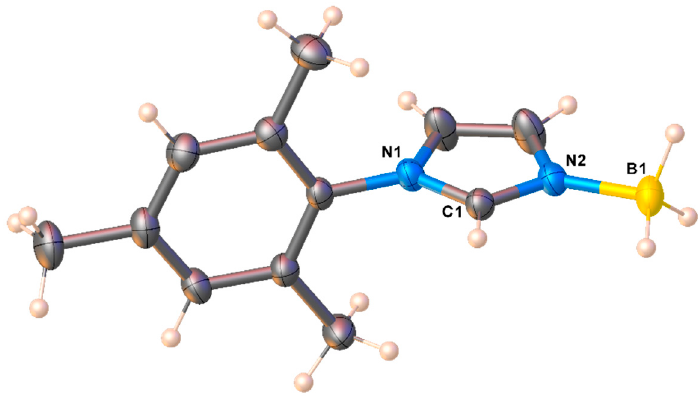
Figure 2. Molecular structure of (HIm Mes )BH 3 (2). There are two chemical similar but crystallographically di ff erent molecules of (HIm Mes )BH 3 in the asymmetric unit but only one is shown here. Selected bond distances (Å) and angles ( ◦ ): N1-C1 1.3442(14), N2-C1 1.3207(14), N2-B1 1.5836(16), N1-C4 1.4465(14), N1-C1-N2 110.36(10), C1-N2-B1 127.91(10).